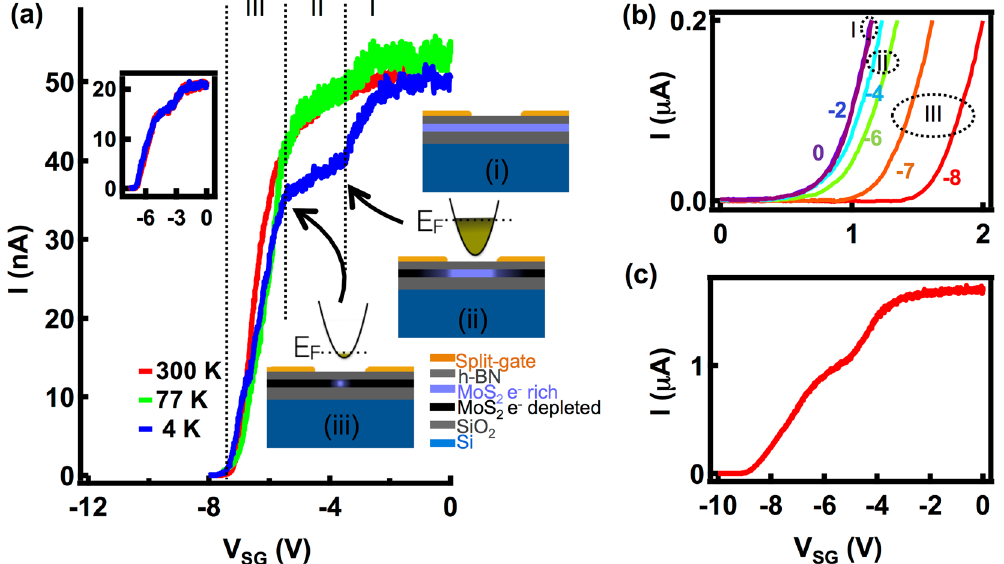
Figure 2. ( a ) Pinch-off characteristics at 4 K (blue), 77 K (green) and 300 K (red) where the on-state current is kept as 50 nA at V BG = 10 V with illustration (i), (ii) and (iii) explaining the different regimes in the transport. The parabolas represent the electrostatic confinement of charge carriers in the point-contact. The inset shows pinch-off curves taken in the forward and the reverse direction showing no hysteresis ( b ) I-V curves as a function of V SG at V BG = 10 V corresponding to different regimes shown in ( a ). V SG is varied from − 8 V (red) to 0 V (violet), the applied V SG values and the corresponding transport regimes are labelled. ( c ) Pinch-off characteristics with an on-state current of 1.7 μ A showing a high on-off ratio > 10 6